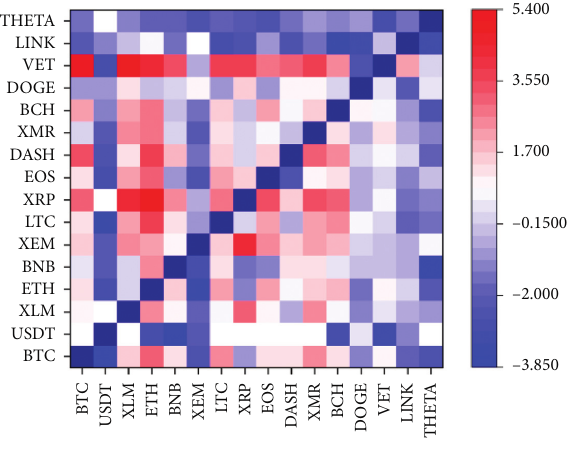
Figure 10: BTC to the other.